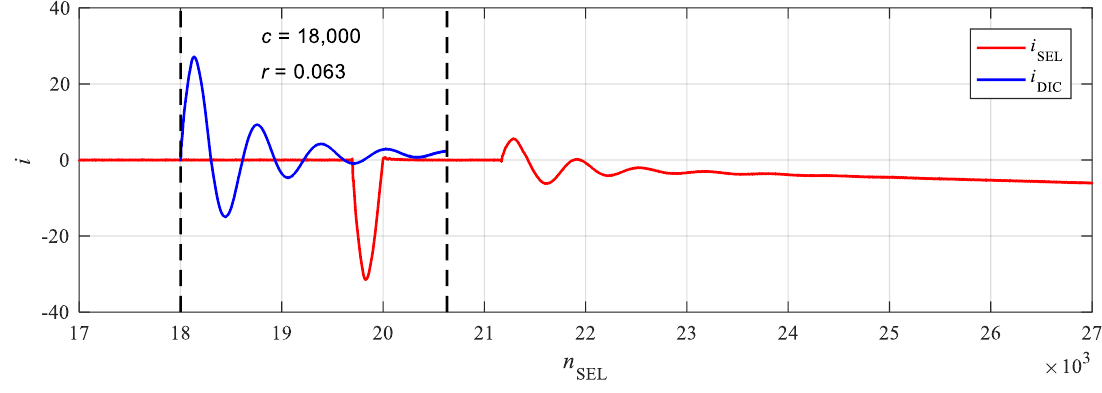
Figure 9. Determining the correlation for sample measurement data, delay c = 18,000.